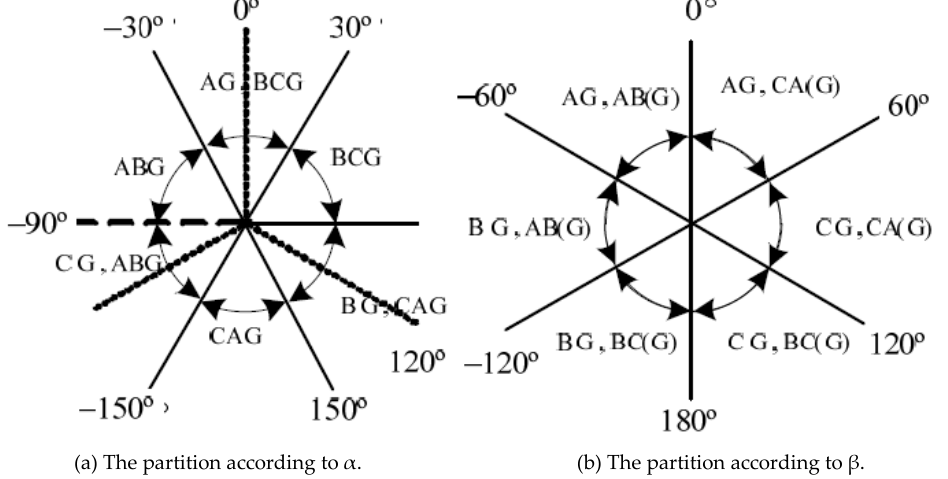
Figure 5. The partitioning of a fault using two phase selector sequence components: ( a ) α based partitioning; ( b ) β based